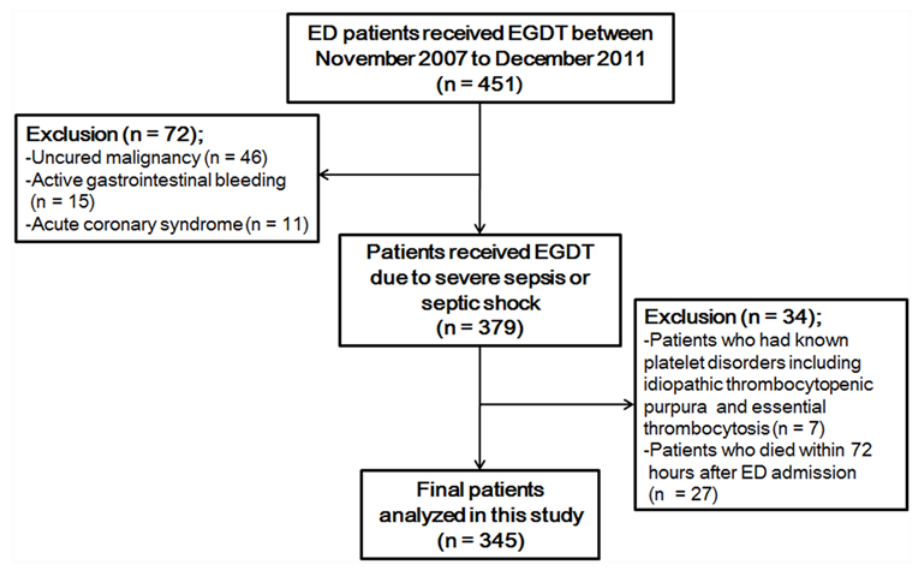
Fig 1. Flow diagram of study patients. From November 2001 to December 2011, 451 patients who received early-goal directed therapy (EGDT) in the emergency department (ED) were assessed for possible enrollment according to inclusion and exclusion criteria, and 345 patients were included in the final